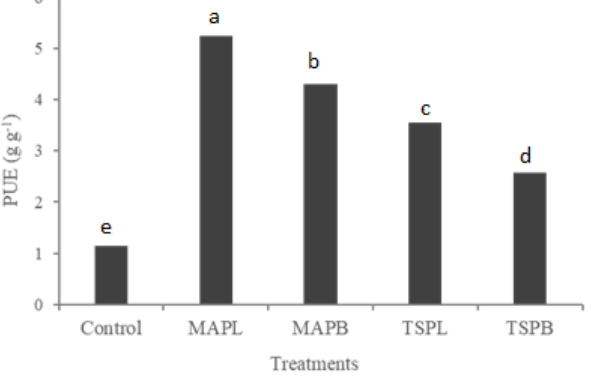
Figure 3. Soybean P-use efficiency (PUE) under two P sources and different forms of P supply. Different letters show significant differences (LSD, p ≤ 0.05). MAP L = MAP applied locally within the soil; MAP B = MAP broadcasted at the soil surface; TSP L = TSP applied locally within the soil; TSP B = TSP broadcasted at the soil surface.